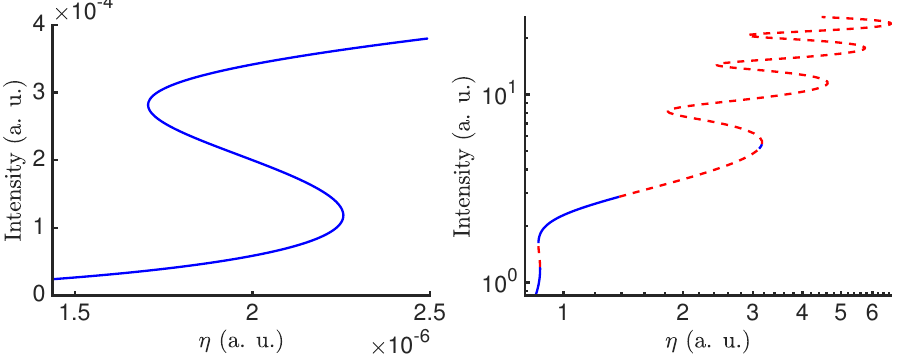
Figure 3. Intensity | A 0 | 2 of CW states (17) and (18) obtained by varying parameter η (left). Here, √ ω 0 = 0, κ = 1 − 10 − 4 , σ = 2.5, α = 1, ϕ = − 3 × 10 − 4 , which in the LLE limit (13) corresponds to ε = 0.01. In the right panel we choose κ = exp ( − 2 ) , ϕ = − 2, which corresponds to ε = 1, where solid lines correspond to stable CWs and dashed - to